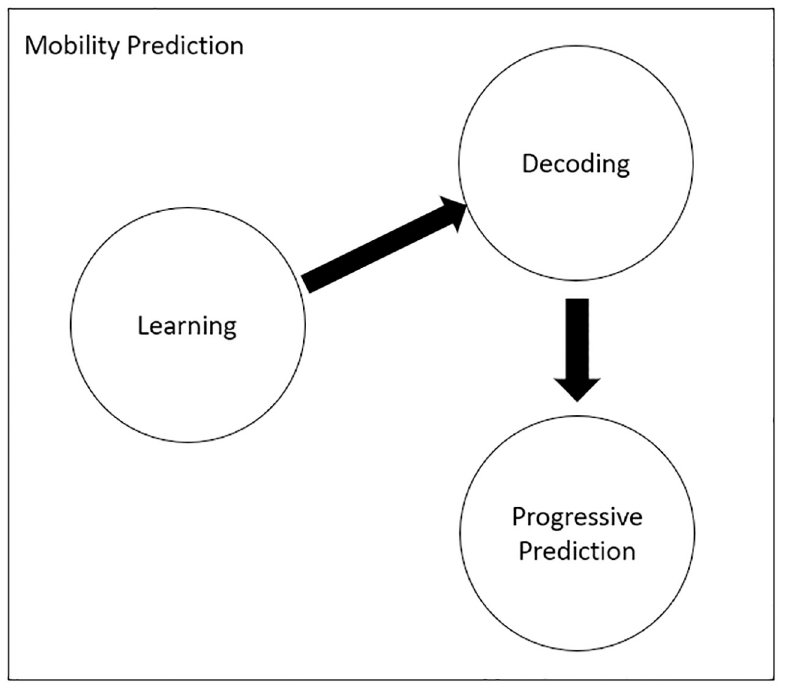
Fig 11. Mobility prediction